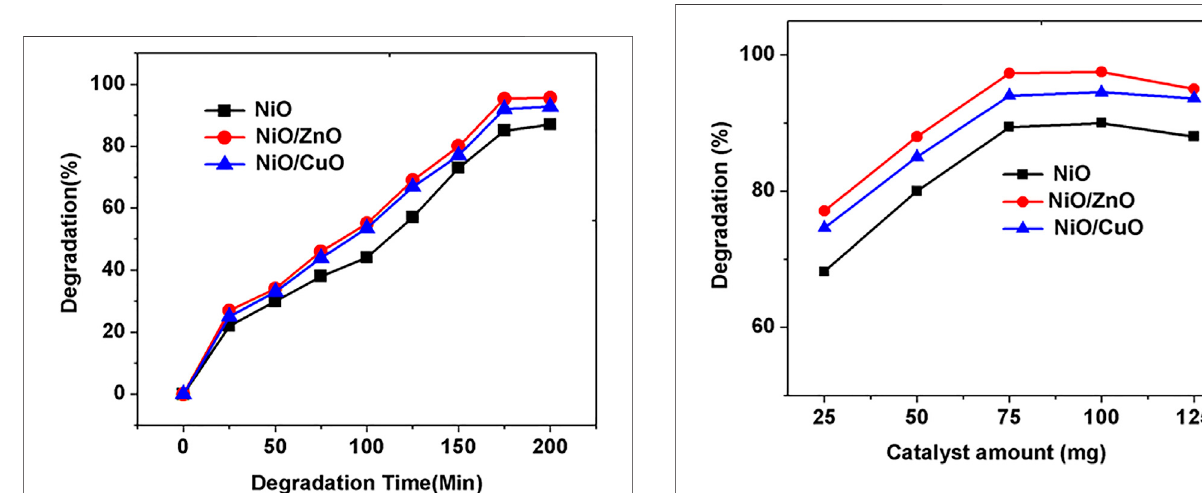
FIGURE 8 | Effect of catalyst amount on MB